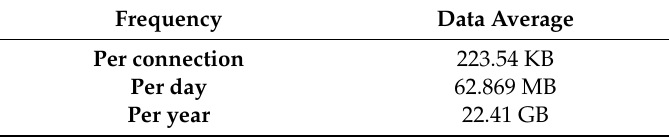
Table 5. Transmission load for 1050 implemented